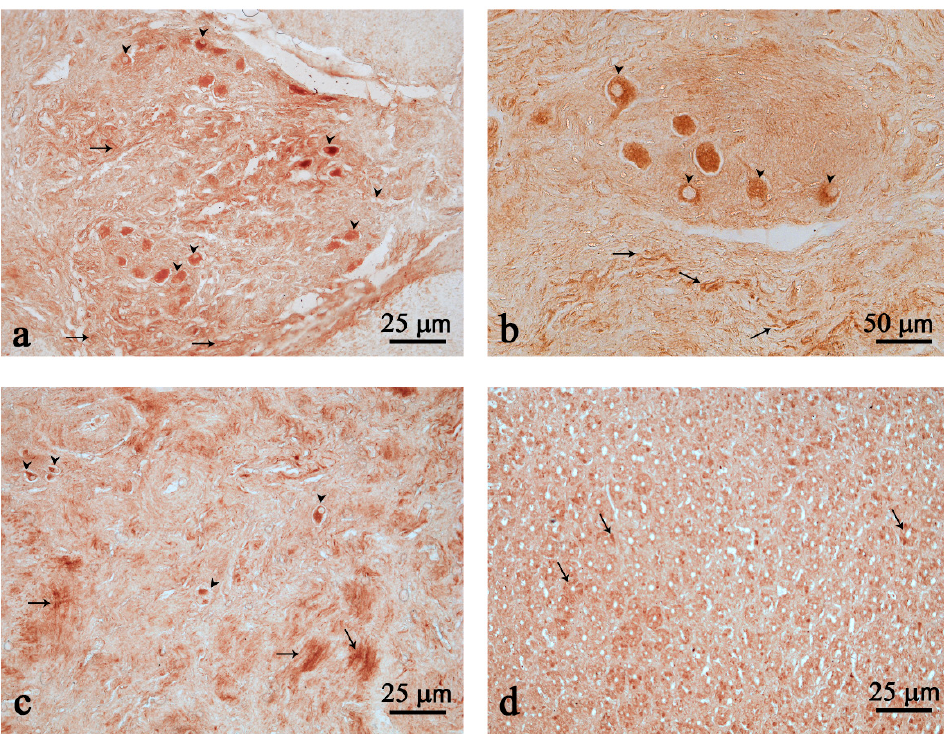
Figure 2. Nesfatin-1 (Nesf-1) immunoreactivity in the third chamber. Nesf-1 distribution in ganglion structures ( a,b ); positive fibers (arrows) ( a – c ); scattered neurons (arrow heads) ( a – c ); mucosal epithelium (arrows) ( d ). Scale bar: ( a , c , d ) = 25 µm; ( b ) = 50 µm.